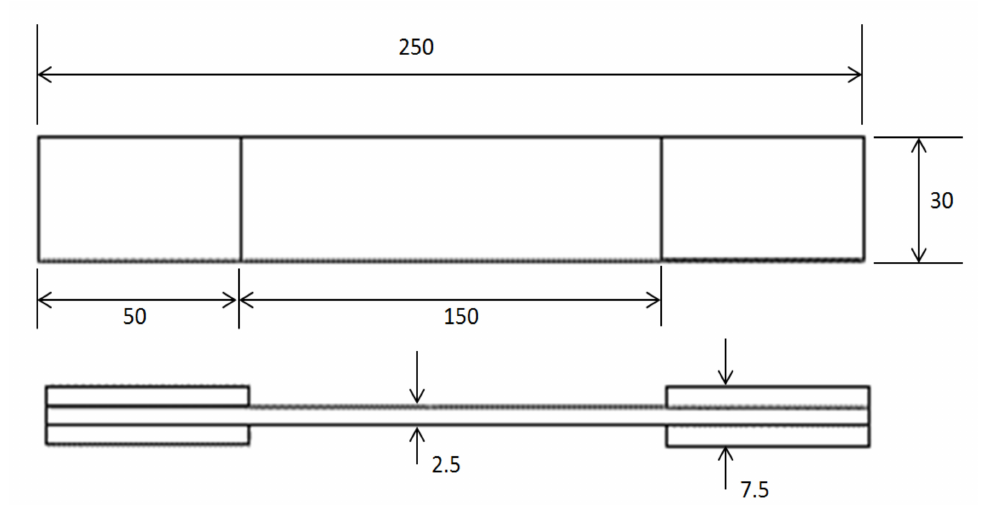
Figure 1. Specimen geometry in mm for tensile specimens according to ASTM D3039/D3039M.